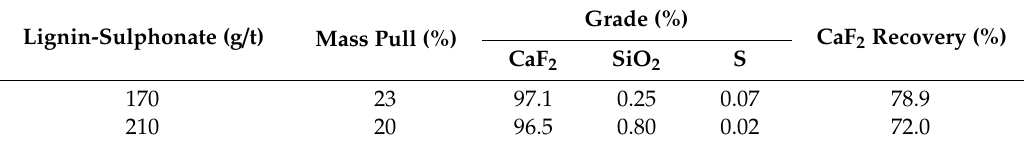
Table 11. E ff ect of lignin sulphonate depressant on S grade as well as CaF 2 grade and recovery. Lignin-Sulphonate (g /